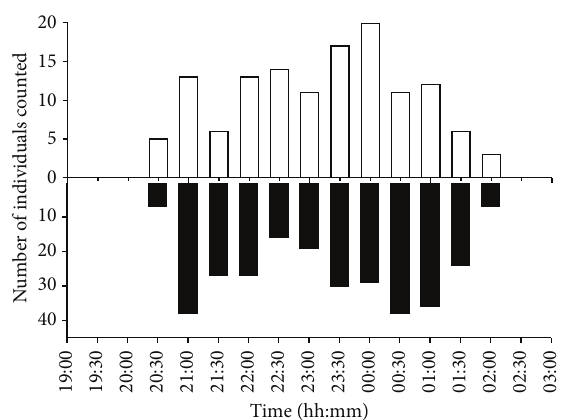
Figure 3: Time of the day for observations of migrating T. cristatus (open bars, April 7-8, 2014) and L. vulgaris (black bars, April 6-7) at Lahelldammen in 2014.